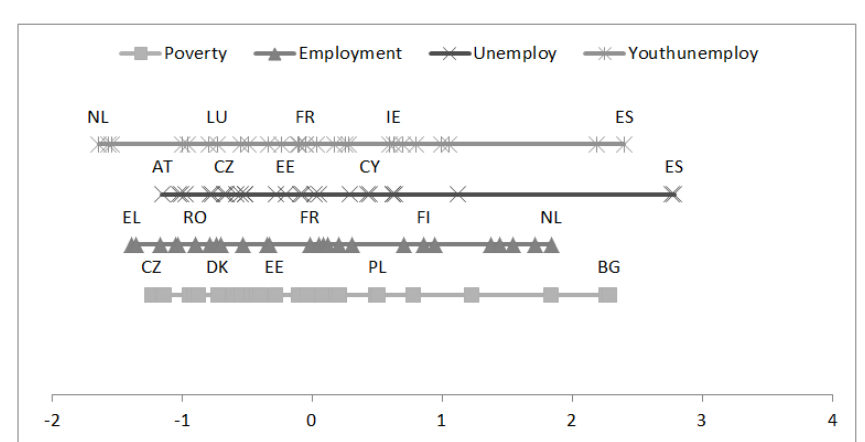
Figure 1 – Display on a line of the standardized values of each variable